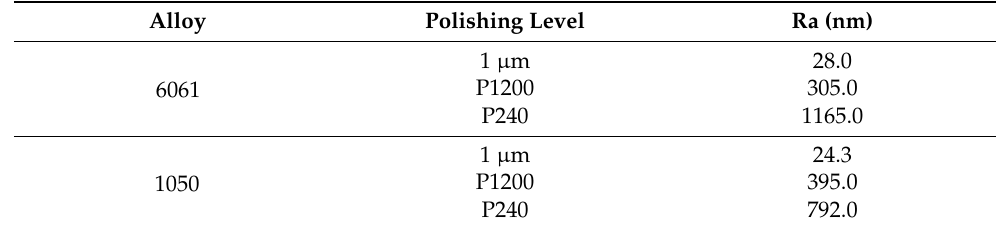
Figure 4. Surface topography of AA1050 and AA6061 specimens before DB experiments characterized by Atomic Force Microscope. The full color scale is 10 µ m. Table 3. Surface roughness Ra of the pre-bonding samples after polishing to different polishing levels.